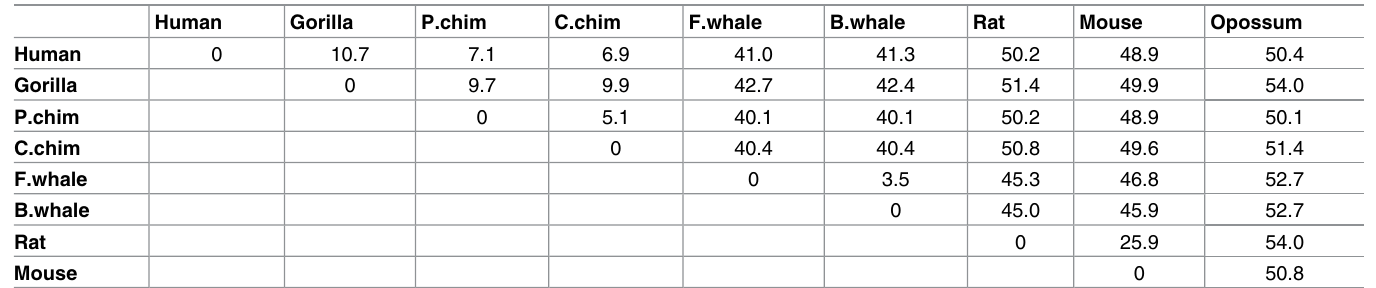
Table 3. The distance matrix of nine species calculated by ClustalW (i.e. Table 4 in [31]). Human